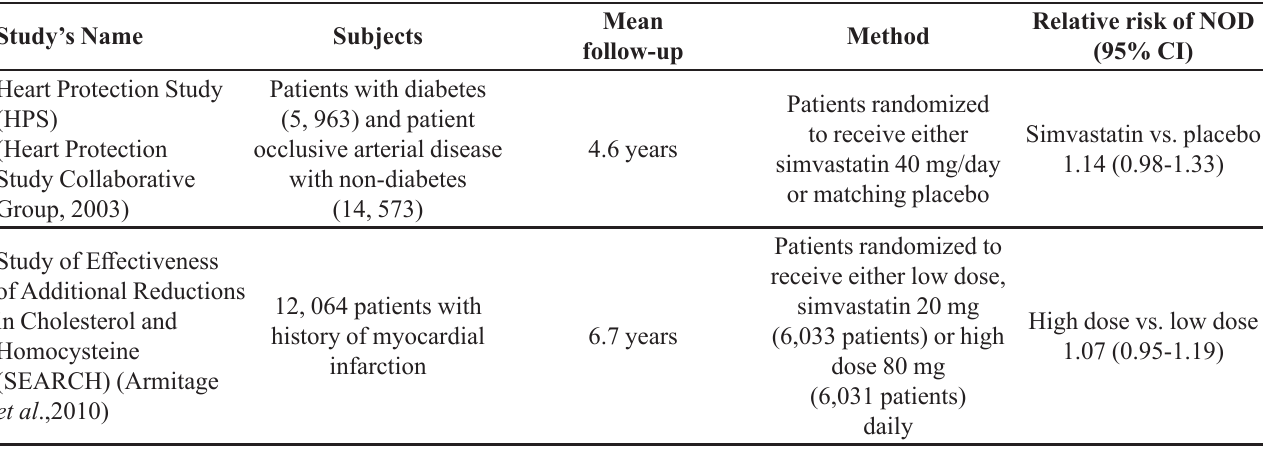
TABLE II - Comparison of relative risk of new-onset diabetes with simvastatin use